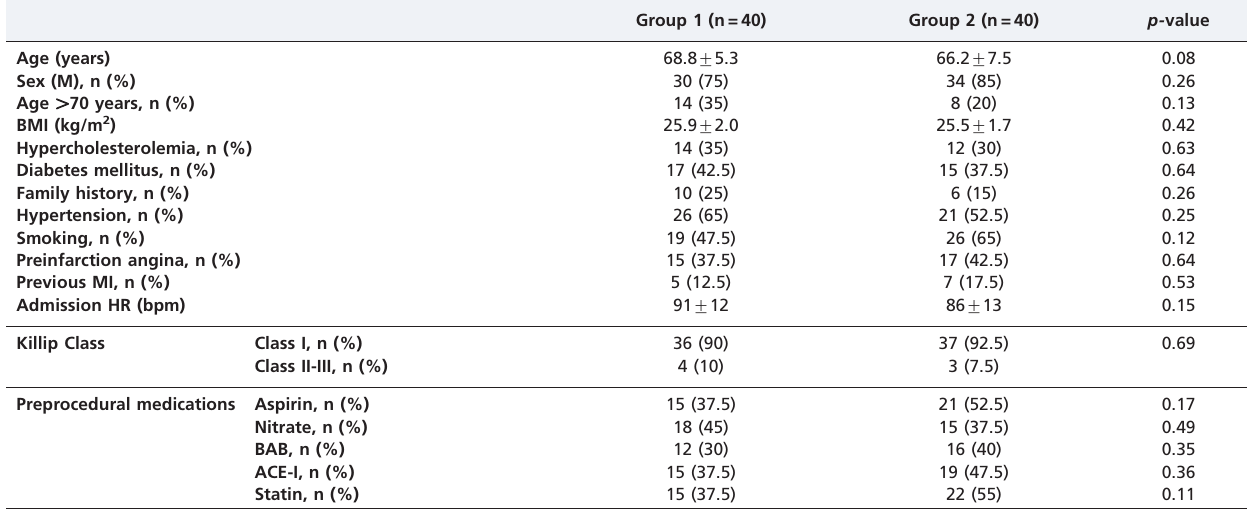
Table 1 - Baseline demographic and clinical characteristics of the study patients.